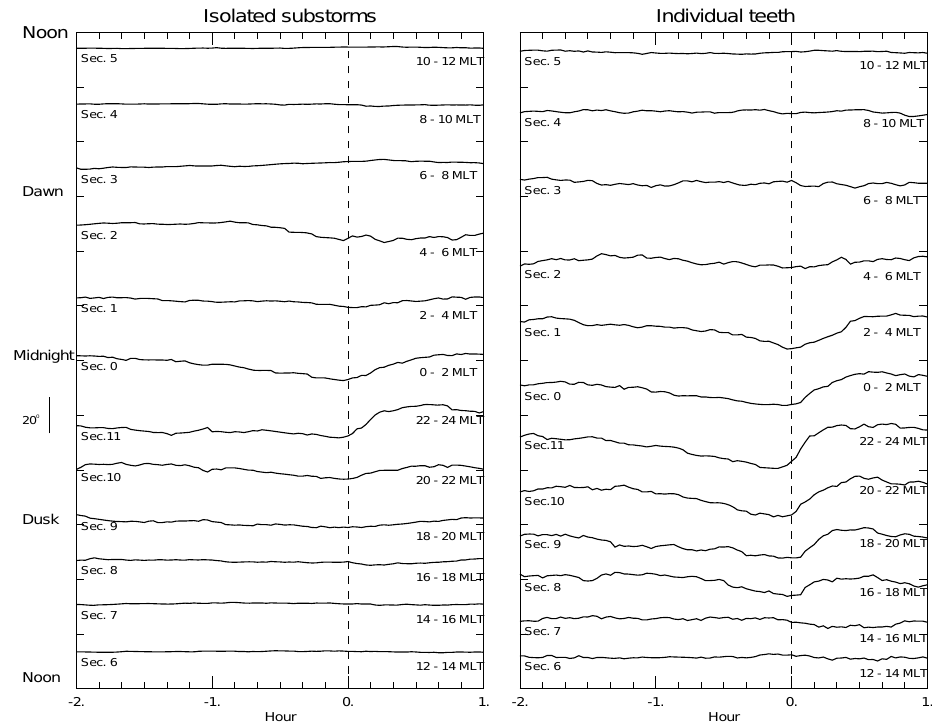
Fig. 2. Stackplots of the average magnetic tilt angle variations for isolated substorms (left) and individual teeth (right) in each sector. Universal time is shown on the X axis where 0 is the onset time. The dashed vertical line is the onset time. Local midnight is in the middle while local noon is on the top and the bottom. The tilt angle is shown in an absolute scale that is identical for both